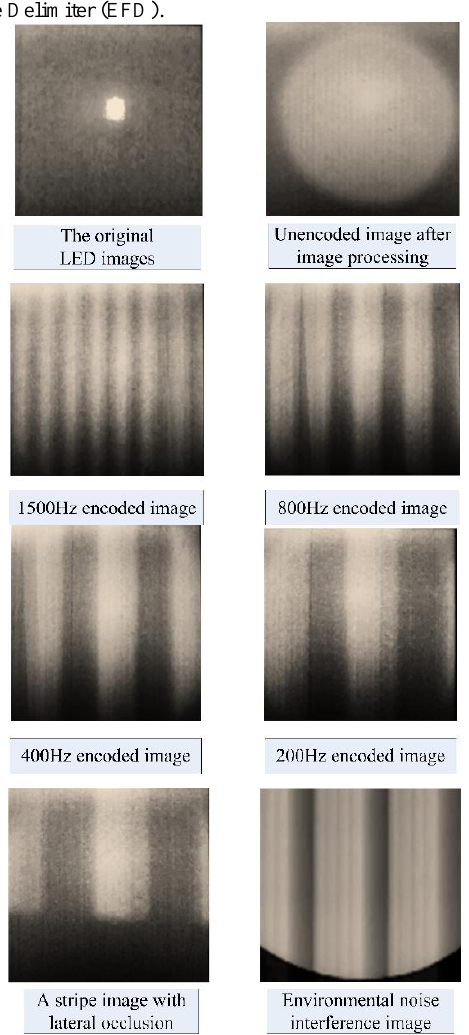
Figure 1 . The positioning system hardware structure.